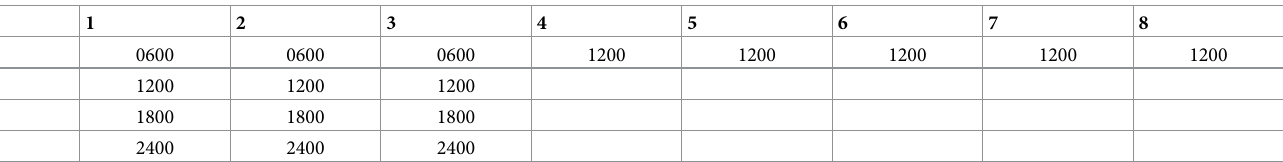
Table 1. Sampling regimen used throughout